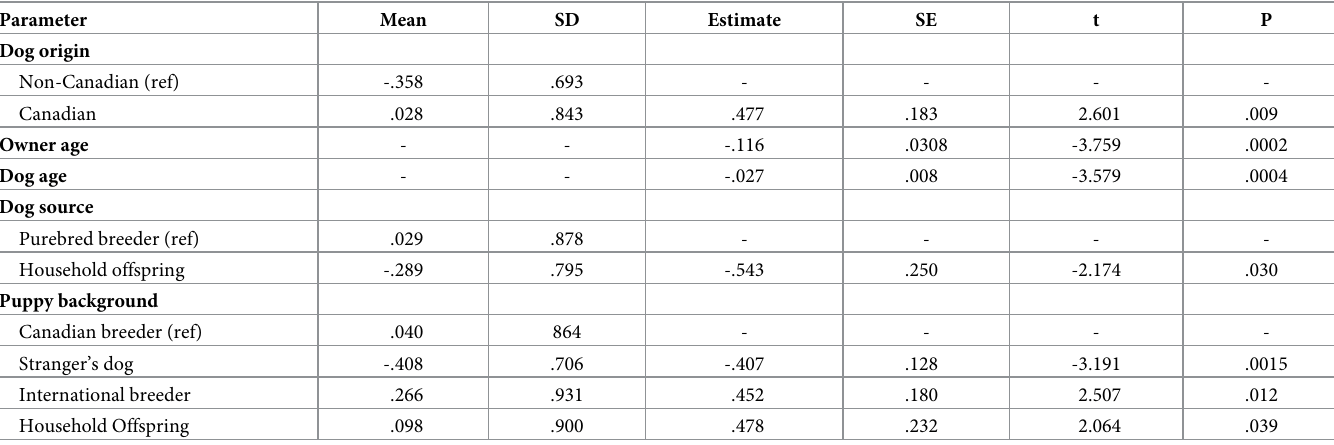
Table 13. Statistically significant interactions of owner and dog parameters on expectation factor “Expectation”.